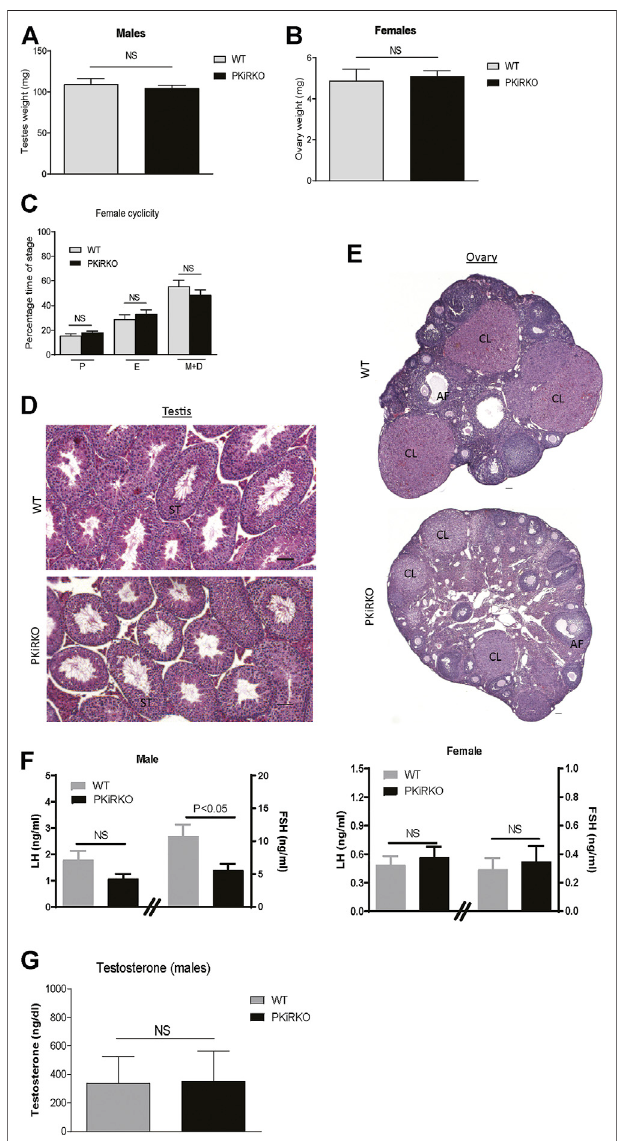
FIGURE 3 | PKiRKO mice have normal reproductive function. (A) . Testes weight was not signi fi cantly different between PKiRKO and WT male mice ( n = 6). (B) Ovary weight was not signi fi cantly different between PKiRKO and WT female mice ( n = 6). (C) Vaginal cytology was examined daily over a period of 14 consecutive days in 6- to 11-week-old mice. WT and PKiRKO groups both exhibited regular estrous cycles the percentage time spentateachcyclestagedidnotdifferbetweengroups. N =6eachgroup. (D) Testis structure between WT and PKiRKO by H&E staining. ST: seminiferous tubule. (E) ovary structure between WT and PKiRKO. CL: copora lutea; AF: antral follicles. There was comparable testis and ovary structure. (F) Morning LH (left Y axis and FSH (right Y axis) in male (left panel) and female (right panel) mice. n = 6, p > 0.05) (G) Testosterone levels are not different between PKiRKO and WT mice ( n = 6 each group). NS = No signi fi cant difference.